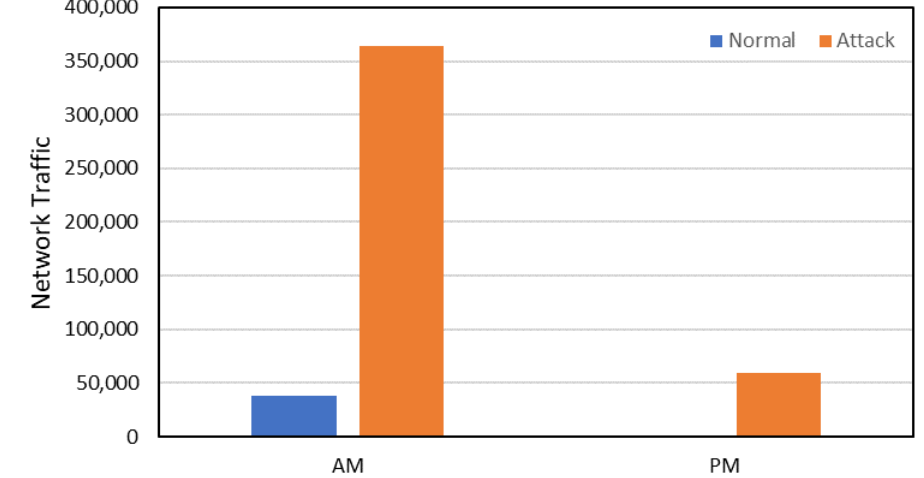
Figure 10. Network traffic in the morning and evening.